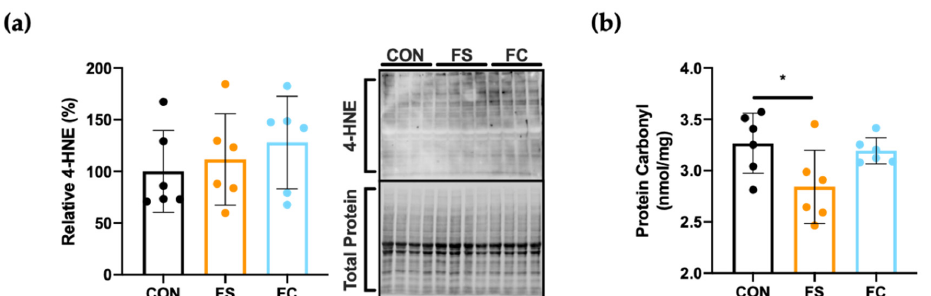
Figure 5. Hippocampal oxidative stress at PD 15. ( a ) To detect lipid peroxidation effects, 4-hydroxynonenal (4HNE) modified proteins were quantified by Western blot ( n = 6/group), normalized to total protein using the Stain-Free™ method, and values with the mean ± SEM are plotted relative to mean CON expression (%). A representative blot with Stain-Free™ total protein blot is shown to the right. ( b ) Protein carbonyl content, a marker of protein oxidation, was quantified in hippocampal tissue lysates by enzyme-linked immunosorbent assay (ELISA; n = 6/group). Values are plotted as the means ± SEM. p -value summary: *, p < 0.05.